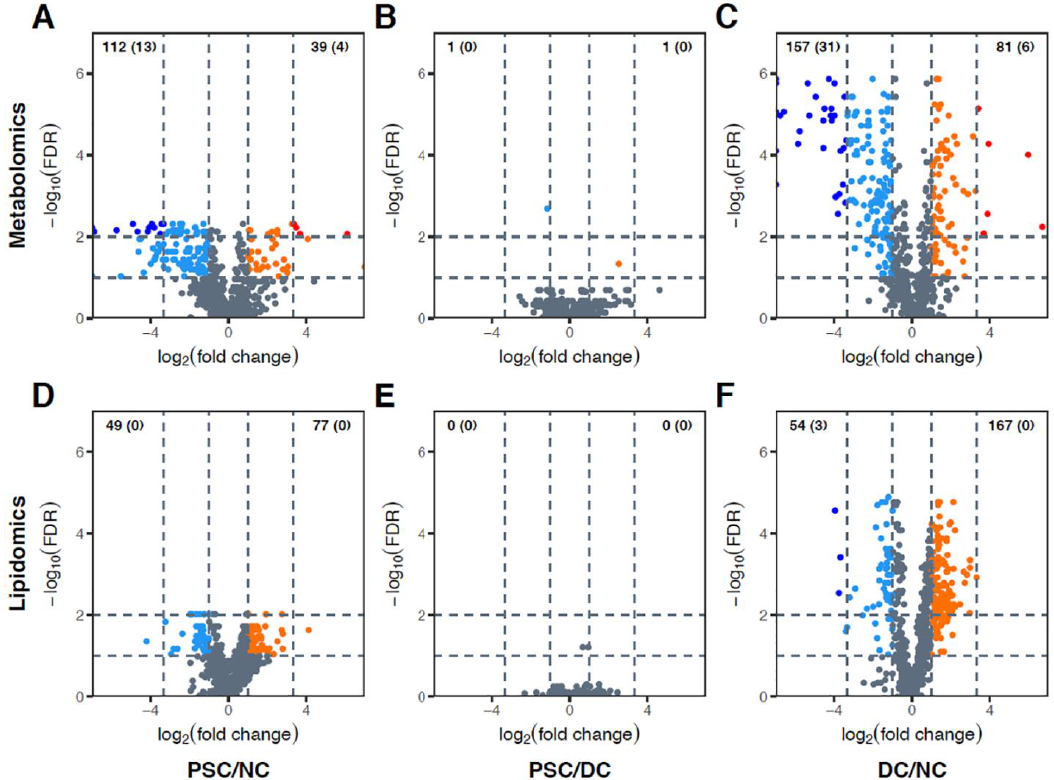
Figure 2. Volcano plots showing differentially abundant metabolites ( A – C ) and complex lipids ( D – F ) in portal serum. Every possible pair of groups, i.e., PSC versus NC ( A , D ), PSC versus DC ( B , E ), and DC versus NC ( C , F ), were compared. The horizontal axis represents direction and magnitude of change in relative intensities, and the vertical axis represents statistical significance of the change. Two different thresholds for fold change (FC) and false discovery rate (FDR) were used: (i) up- (orange) and downregulated (sky blue) metabolites (FC > 2 and FDR < 0.1); and (ii) very significantly up- (red) and downregulated (blue) metabolites (FC > 10 and FDR < 0.01). Note that very significantly up- and downregulated metabolites are subsets of up- and downregulated metabolites, respectively. Numbers shown in the upper-left and -right corners of each panel represent counts of up- and downregulated metabolites, respectively. Numbers in parentheses represent counts of very significantly up- or downregulated metabolites.